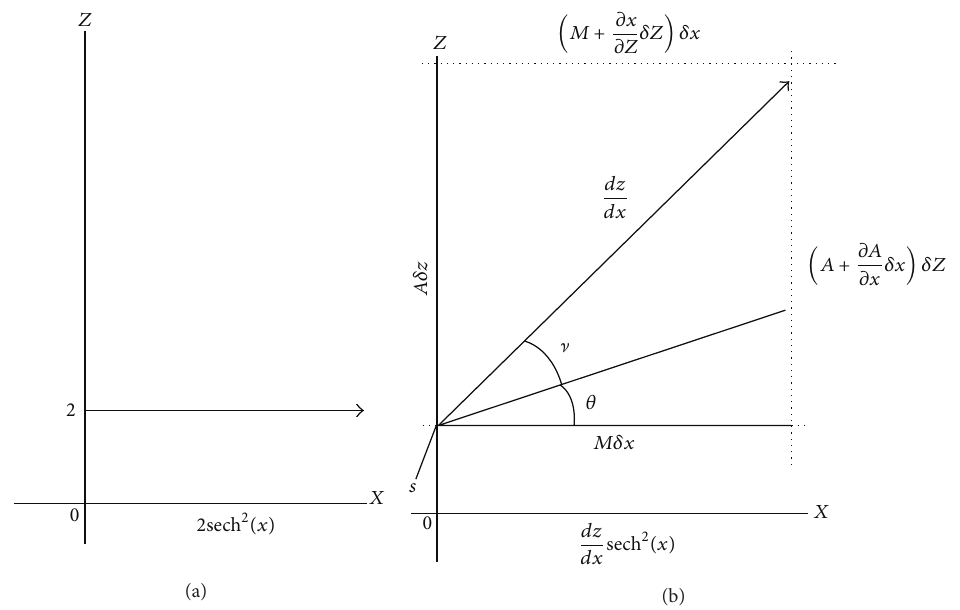
Figure 1: The nonlinear waves. (a) The nonlinear wave propagates with amplitude 2 in 𝑥 -direction. (b) The nonlinear waves propagate with variation amplitude 𝑑𝑧/𝑑𝑥 , initiated by reflection at incline beach plane. There is an incidence of seismic plane waves, 𝑠 from the seabed whereas the seismic plane waves suffer diffraction